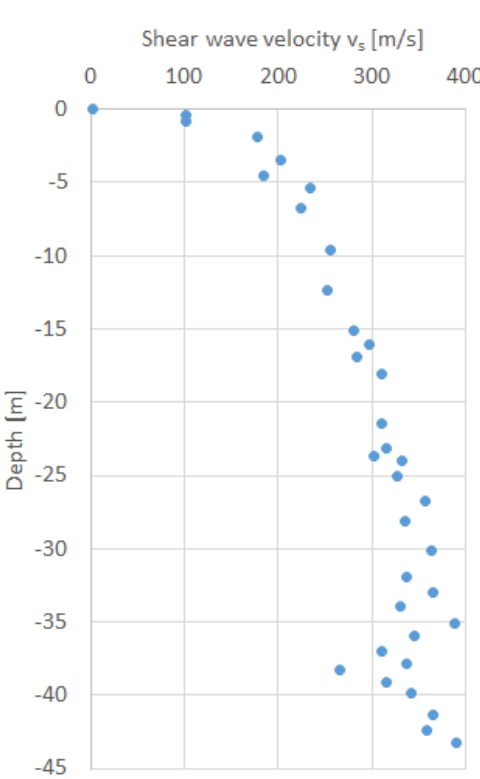
Figure 5. Shear wave velocity ( v s ) profile at project site. Table 5. Soil data of the application case.